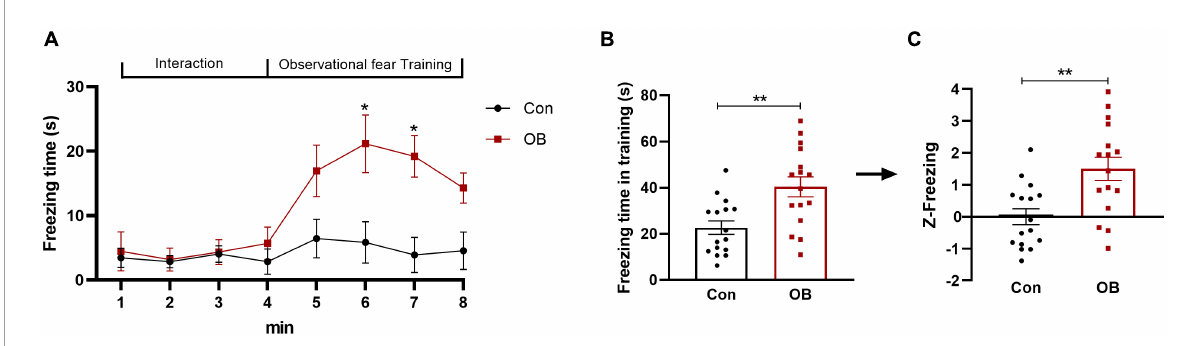
FIGURE2 Freezing behavior and emotionality Z -score in FZ. (A,B) A significant difference in the level of freezing behavior was apparent during the observational fear training and retrieval phase. (C) Normalization of data using the Z -score method was performed for the freezing time of each mouse in the training phase. Control group: OB mouse paired with a no-shock DM mouse. Model group: OB mouse paired with a foot-shock DM mouse. Data are expressed as mean ± SEM ( n = 16) and compared by unpaired t -test (B,C) or two-way ANOVA followed by Bonferroni’s multiple comparison test (A) . * p < 0.05, ** p <